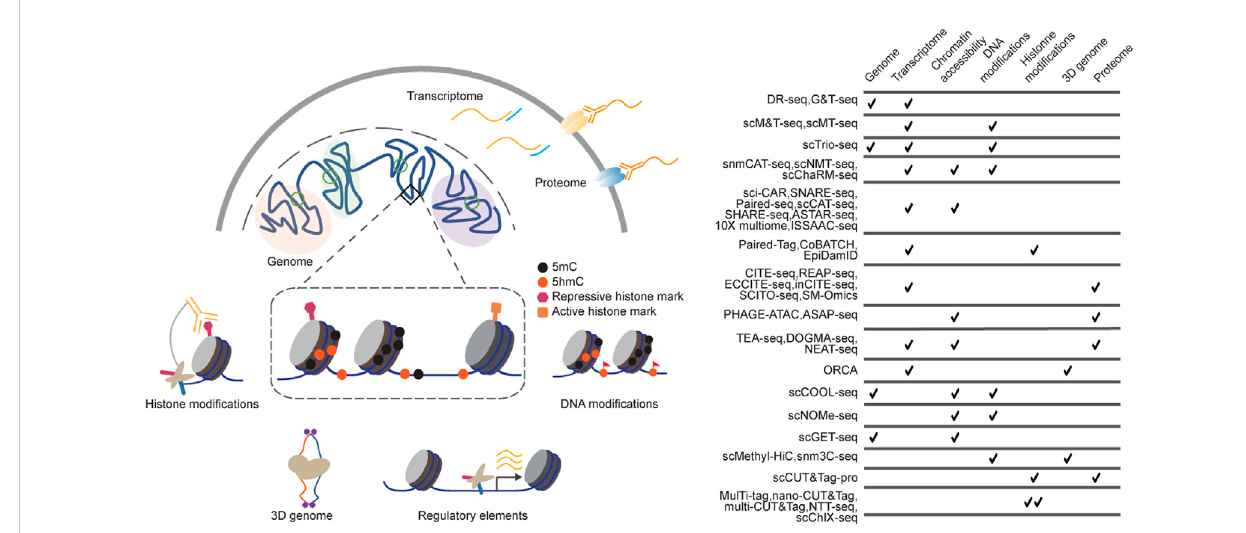
FIGURE 1 Technologies for single-cell multimodal measurements. (A) Single-cell multi-omics methods have been developed to pro fi le DNA sequences, chromatin states, and gene expression from the same cells. Single-cell multimodal omics methods are designed on various strategies, including Tn5 tagmentation, proximity ligation, immunoprecipitation, and chemical labelling, among which they perform high biocompatibility and orthogonality; (B) the table summarizes some of the current single-cell multi-omics sequencing